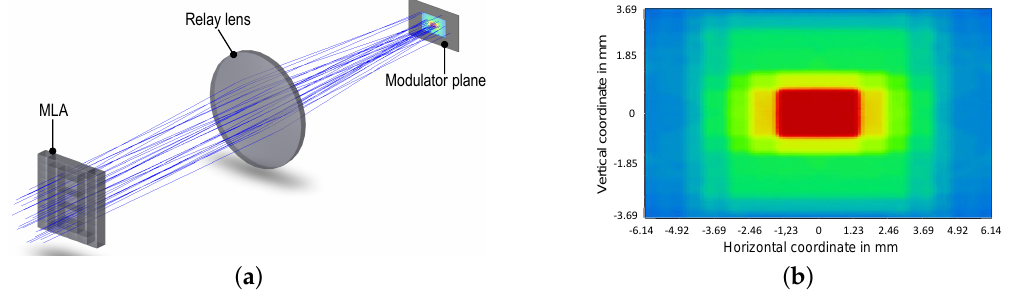
Figure 10. Simulation model and its result for the hotspot generation based on the modification of focal length. ( a ) Simulation model; ( b ) Detector view located at the modulator plane